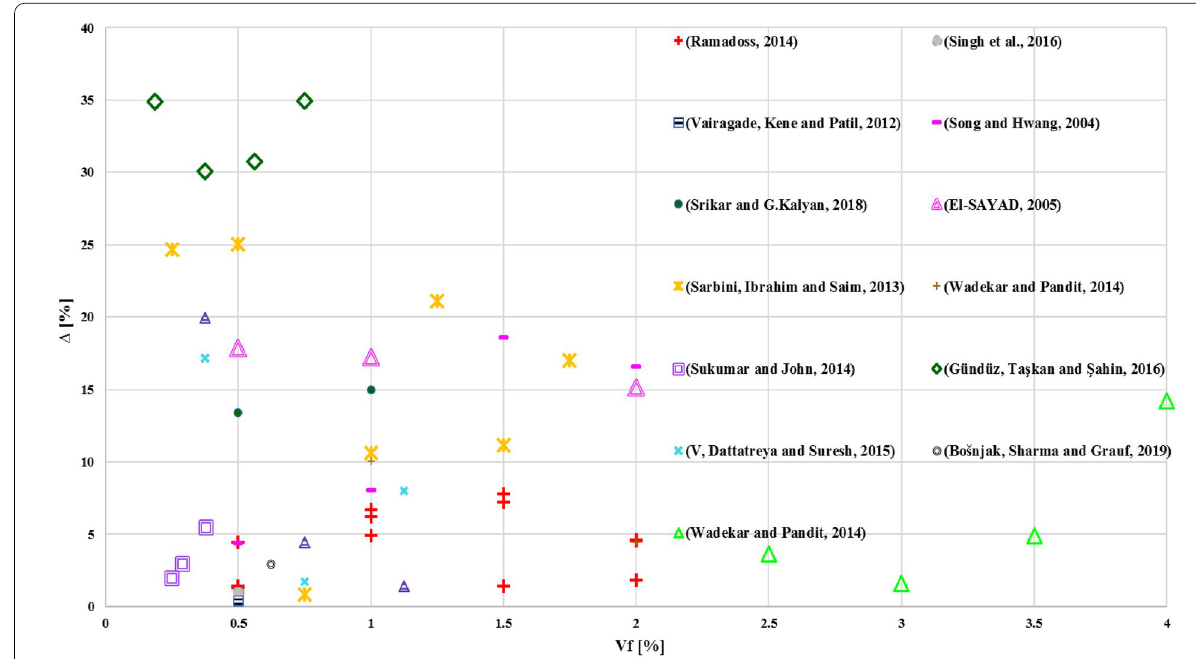
Fig. 7 Comparison of evaluated tensile strength and previous experimental results.